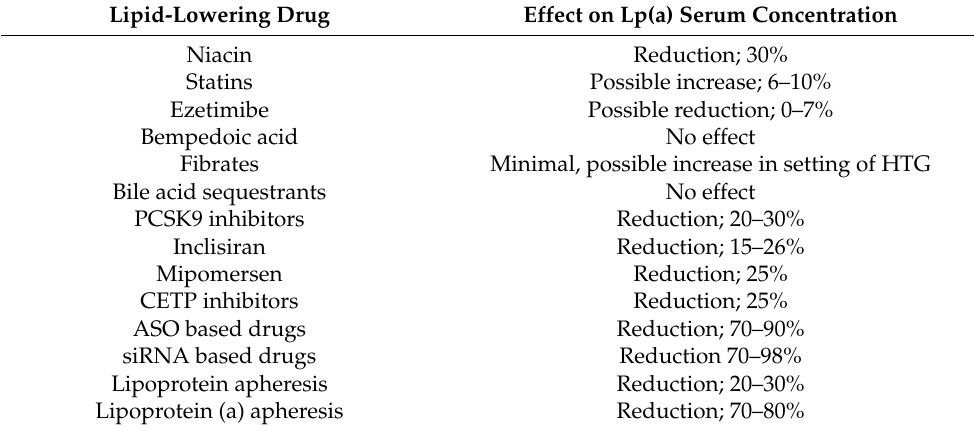
Table 2. Effect of lipid-lowering drugs on Lp(a) serum concentration